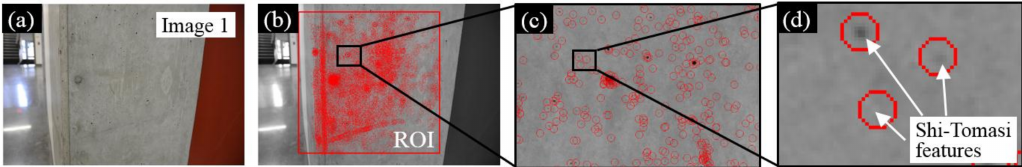
Figure 2. Demonstration of feature detection using an image of a concrete column. ( a ) First input image; ( b ) 15,117 feature points are detected in the ROI; ( c ) detailed look of Figure 2b; and ( d ) detailed look of Figure 2c. Red circles in Figure 2b–d are Shi–Tomasi features.